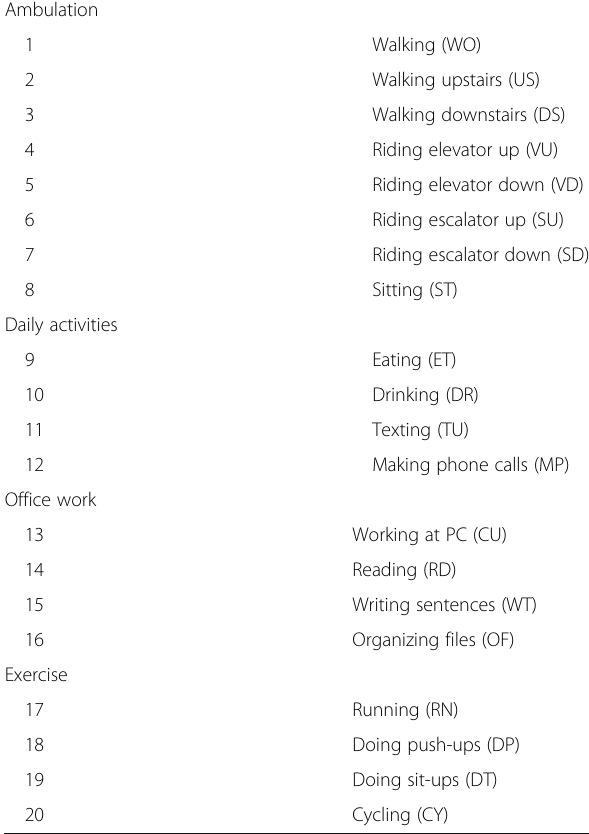
Table 8 Activity categories of the egocentric activity dataset